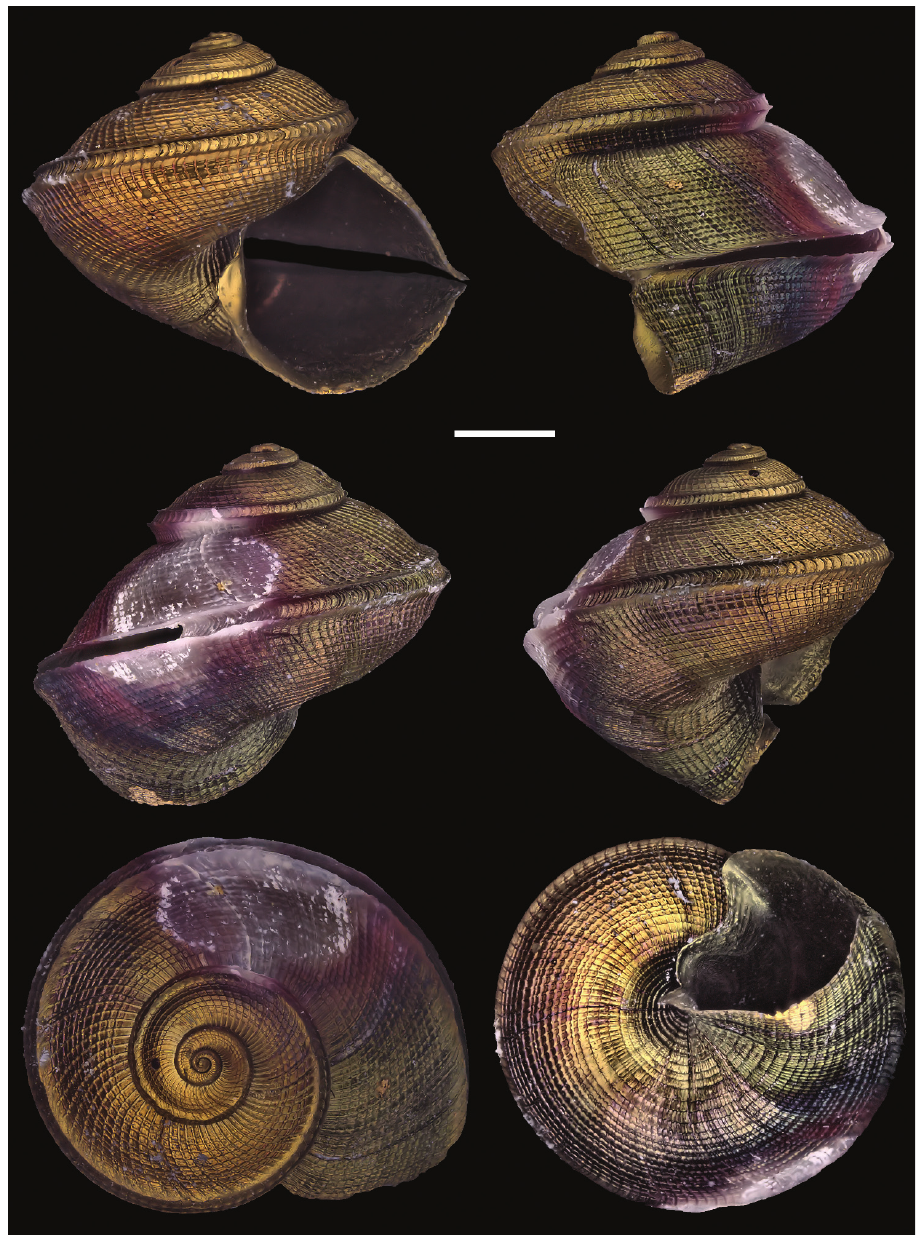
Figure 18. Anatoma yaroni Herbert, 1986. Holotype T3258/NMSA-MOL 0C6590. Scale bar: 1 mm.